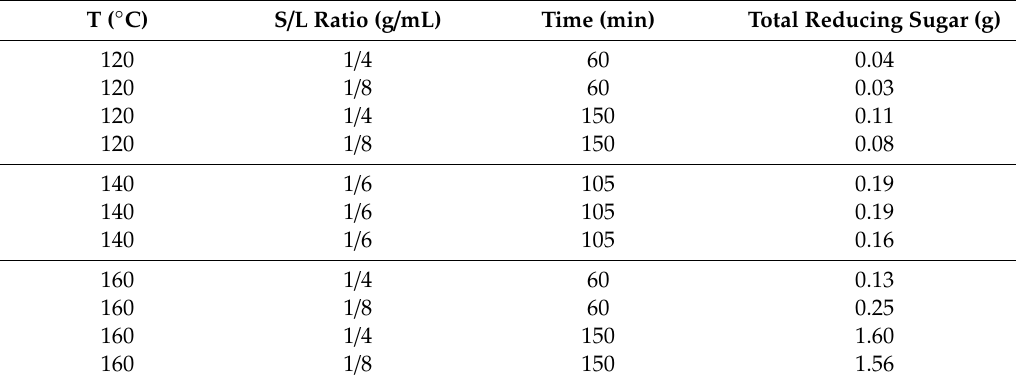
Table 2. Results from the 2 2 factorial design of hemicellulose